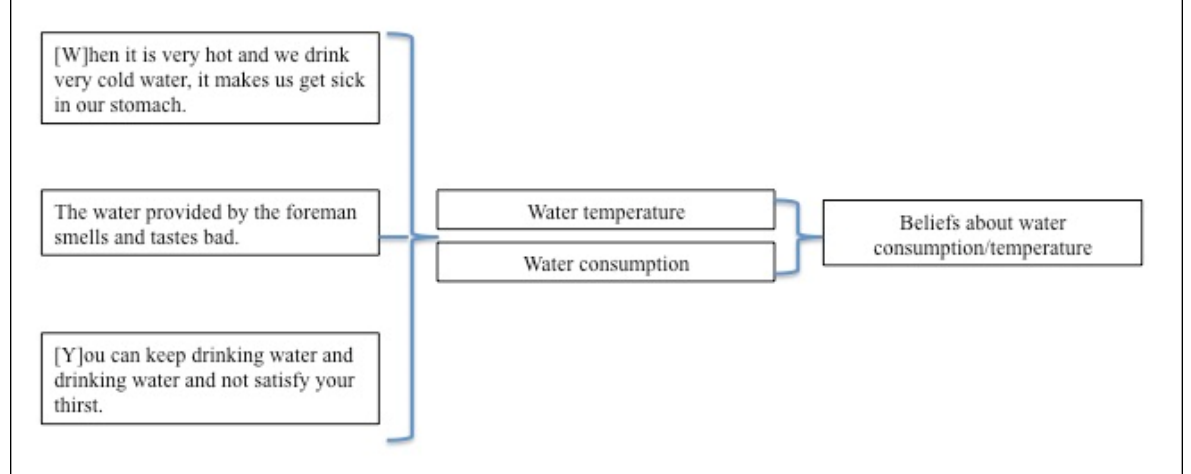
Figure 3. Sample Factor Cluster Construction Moving from left to right, responses related to participants’ beliefs about water are categorized into two shared subgroups that ultimately form a factor